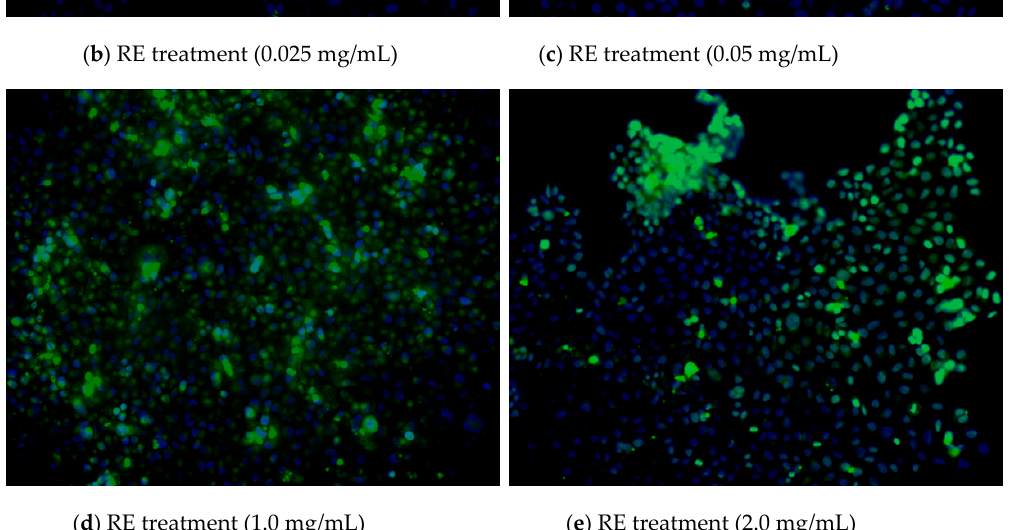
Figure 6. Images of DAPI staining (green color) and TUNEL (blue color) to indicate the MCF-7 cell apoptosis.